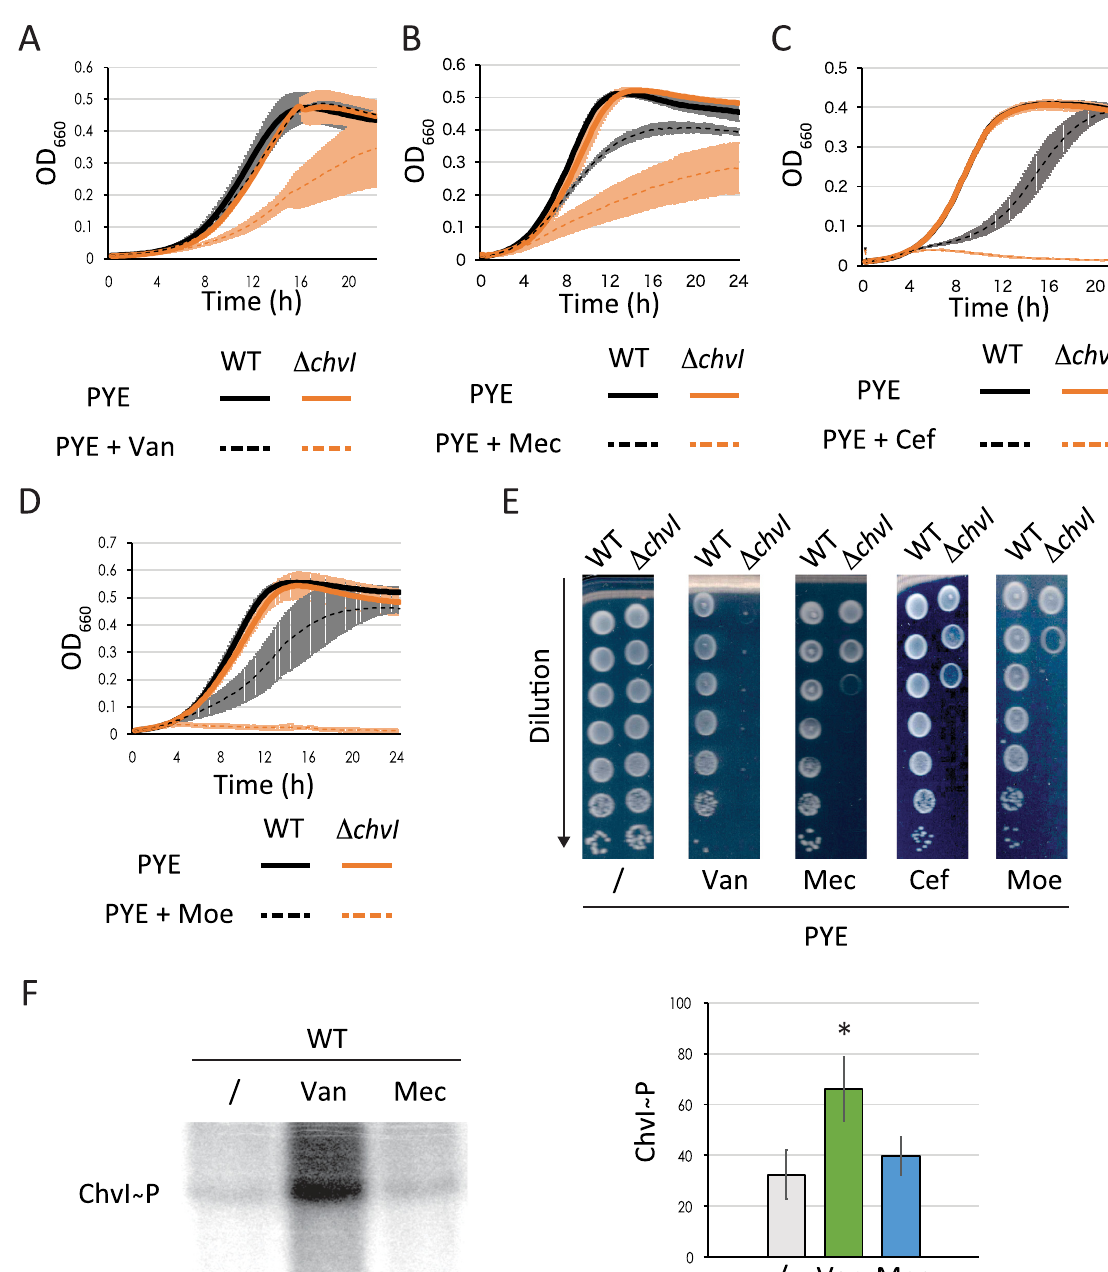
Fig 5. ChvI responds to treatment with antibiotics targeting transpeptidation of peptidoglycan during elongation ( A-D) Growth of WT and Δ chvI mutant cells in PYE supplemented with either vancomycin (Van) (A), mecillinam (Mec) (B), cefsulodin (Cef) (C) or moenomycin (Moe) (D). (E) Viability of WT and Δ chvI mutants upon treatment with the antibiotics indicated above. Images are representative of three biological replicates. (F) Quantified in vivo phosphorylation levels of ChvI in WT grown in M5GG without antibiotics (/) or with 10 μ g/ml vancomycin (Van, green) or 100 μ g/ml mecillinam (Mec, blue) for 7 min. The data in figures (A-D) and (F) represent the average values of biological replicates (n = 3, error bars show standard deviation). � = p < 0.05, single factor ANOVA analysis of ChvI phosphorylation. WT and Δ chvI mutants are represented in (A) to (D) in black and orange,